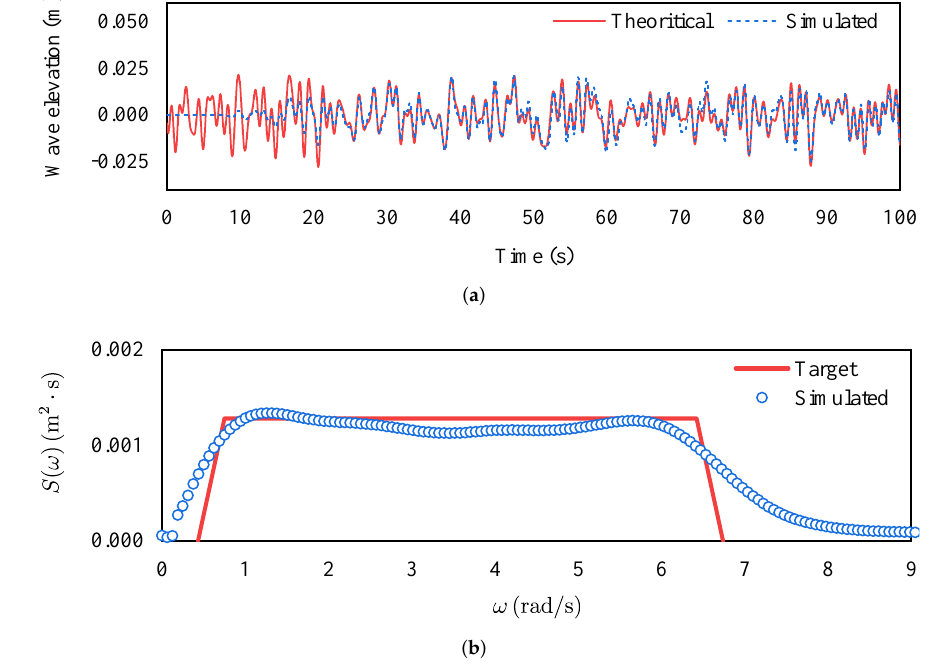
Figure 8. Simulation results of the white noise spectrum case. ( a ) Profile of the wave elevation monitored by the wave gauge at x = 6.0m. ( b ) Comparison between the target spectrum and simulated